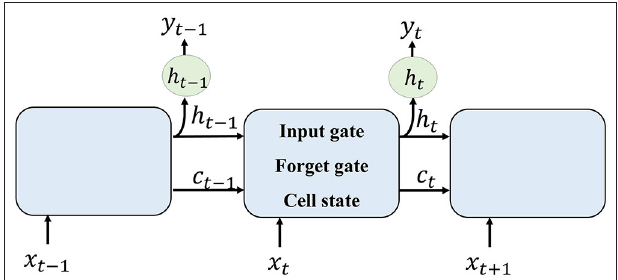
FIGURE 2 | Recurrent neural network (RNN) method